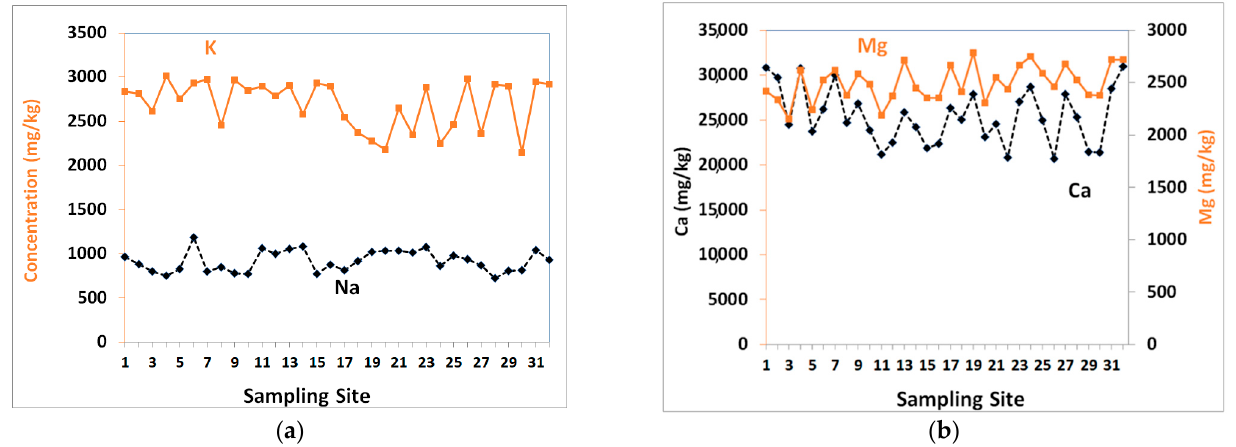
Figure 4. The concentrations of ( a ) Na, and K, ( b ) Ca and Mg in the soil samples collected from Liwa